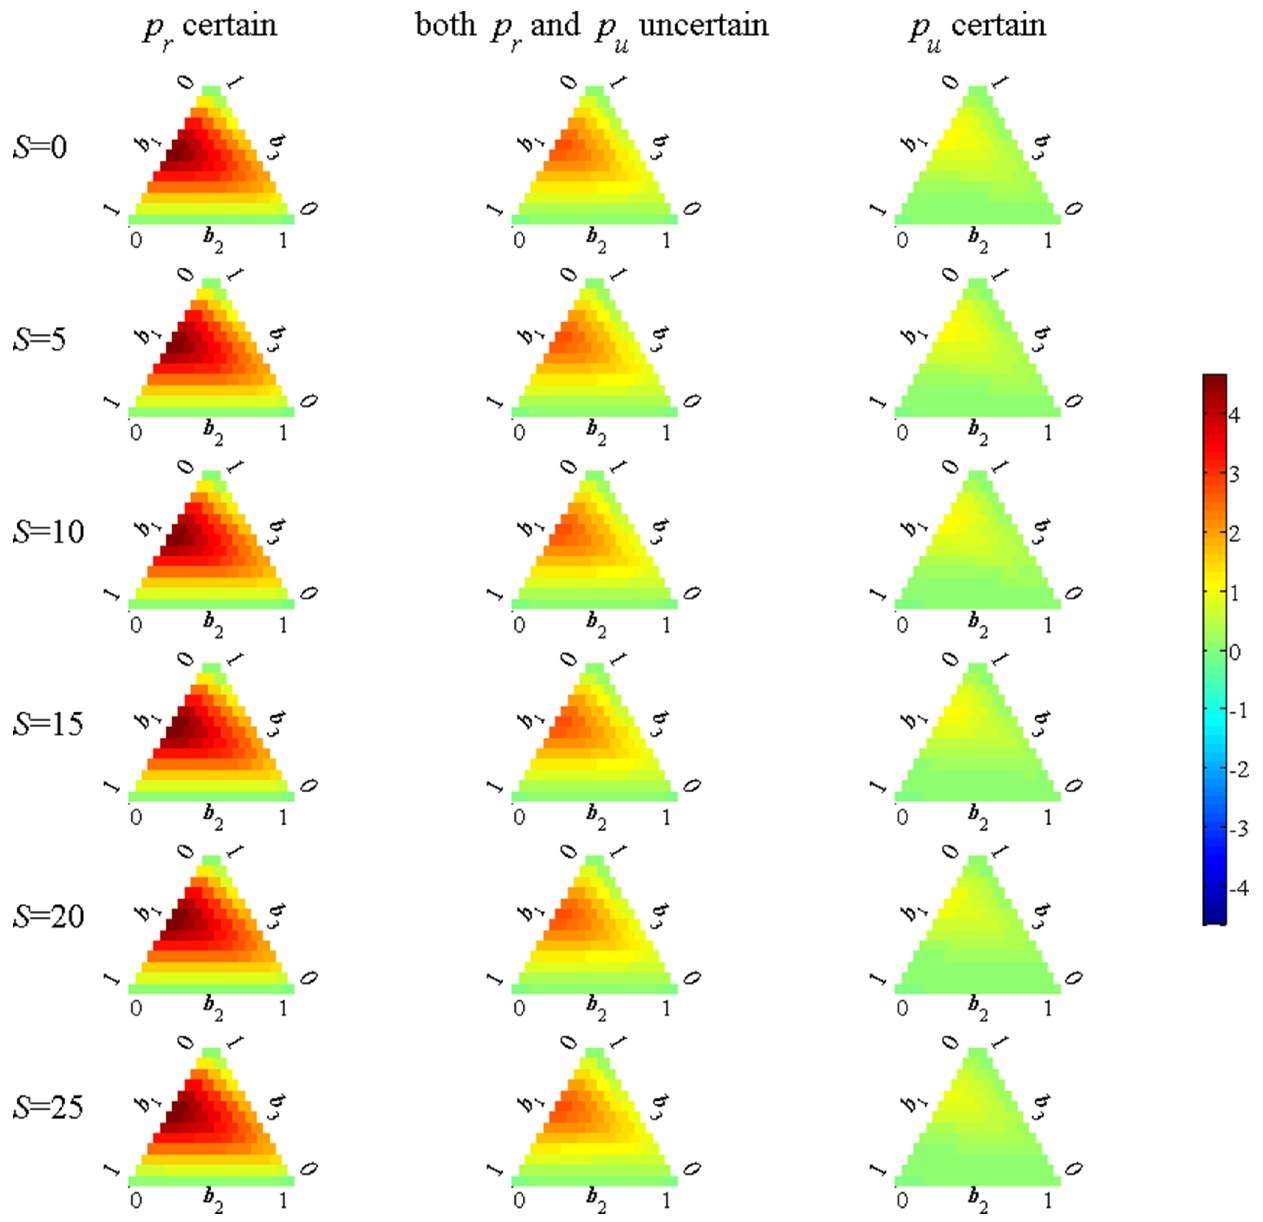
Figure 4. Comparison of value results from use of signal. Each subplot gives the percent increase in value using the best signal relative to the no signal case. Green values indicate equal value, blue values represent decrease in value with the signal, yellow/red values indicate an increase in value with the signal.